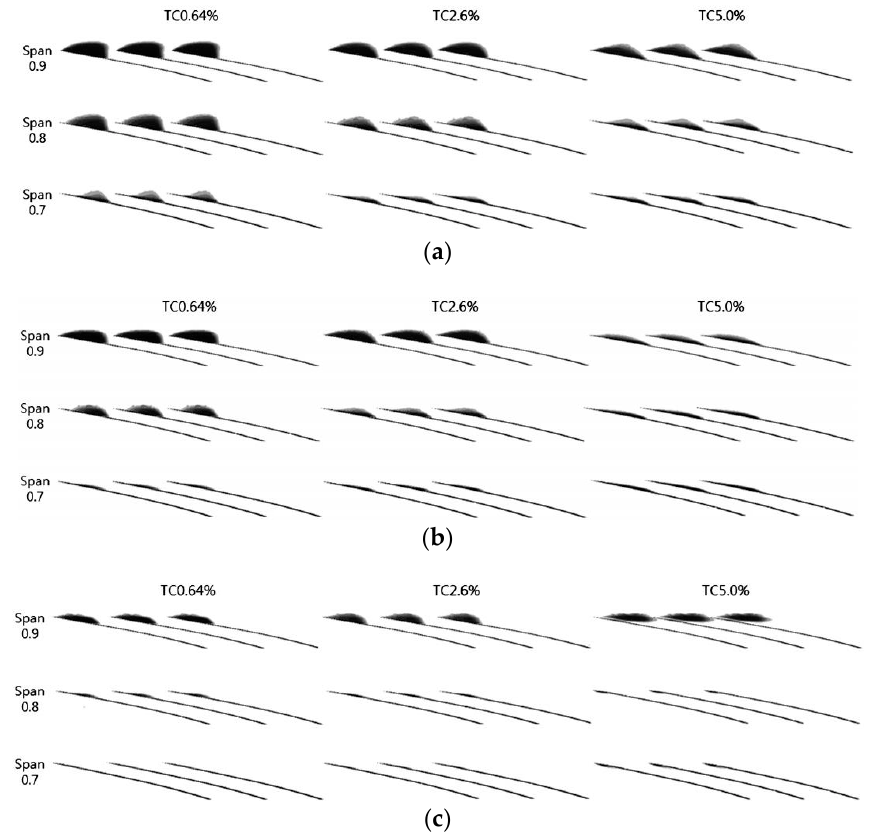
Figure 26. Cavitation pattern with different tip clearances: ( a ) σ = 0.05 at 0.8 Q d ; ( b ) σ = 0.05 at 1.0 Q d ;( c ) σ = 0.07 at 1.2 Q d [55]. Note: In Figures 25 and 26, TC is the ratio of tip clearance to radius, Q d is the design flow rate, and σ is cavitation number.